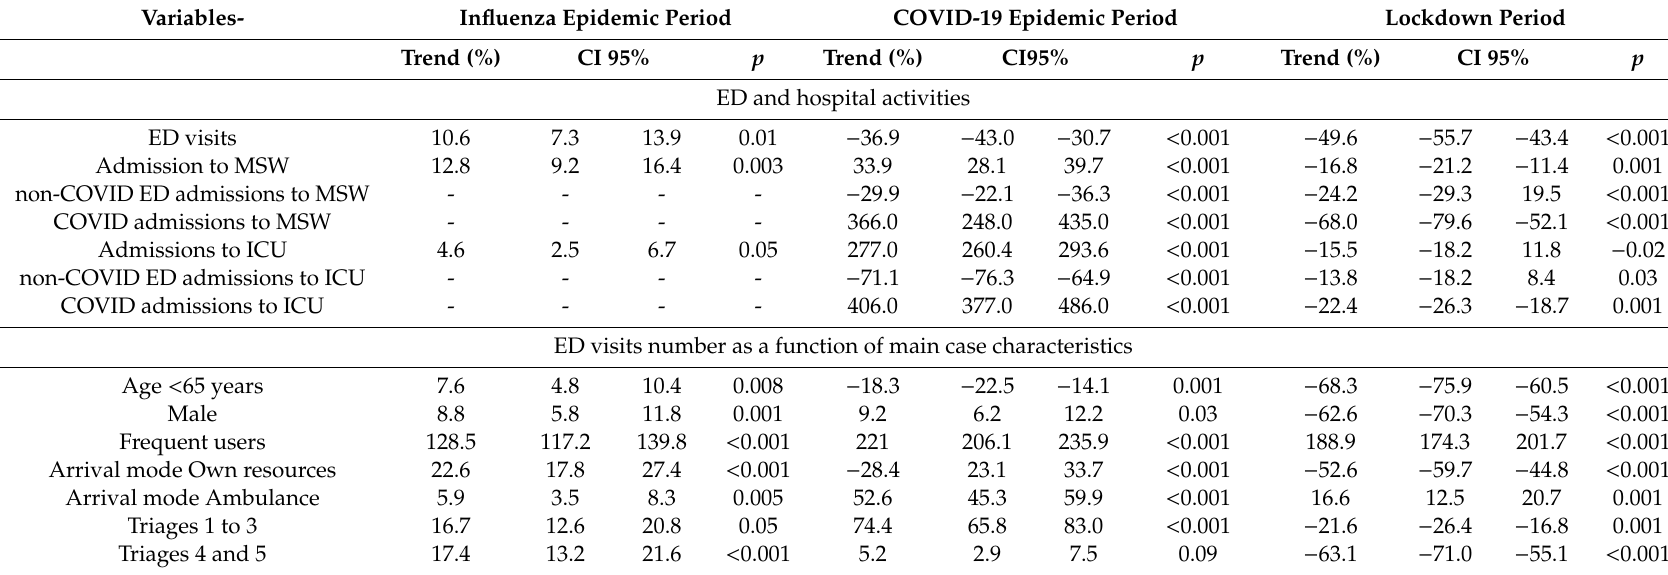
Table 3. Time series analysis models for influenza epidemic, COVID-19 epidemic and lockdown